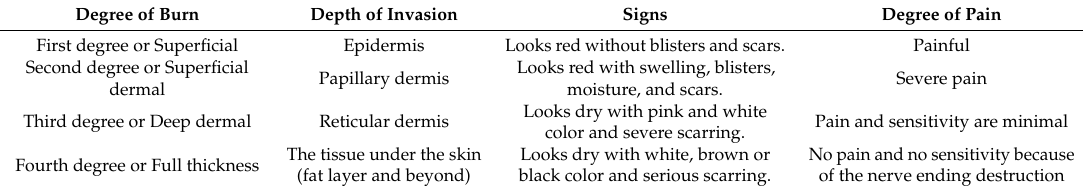
Table 1. Overview of the main characteristics and features of the burn damaged skin.